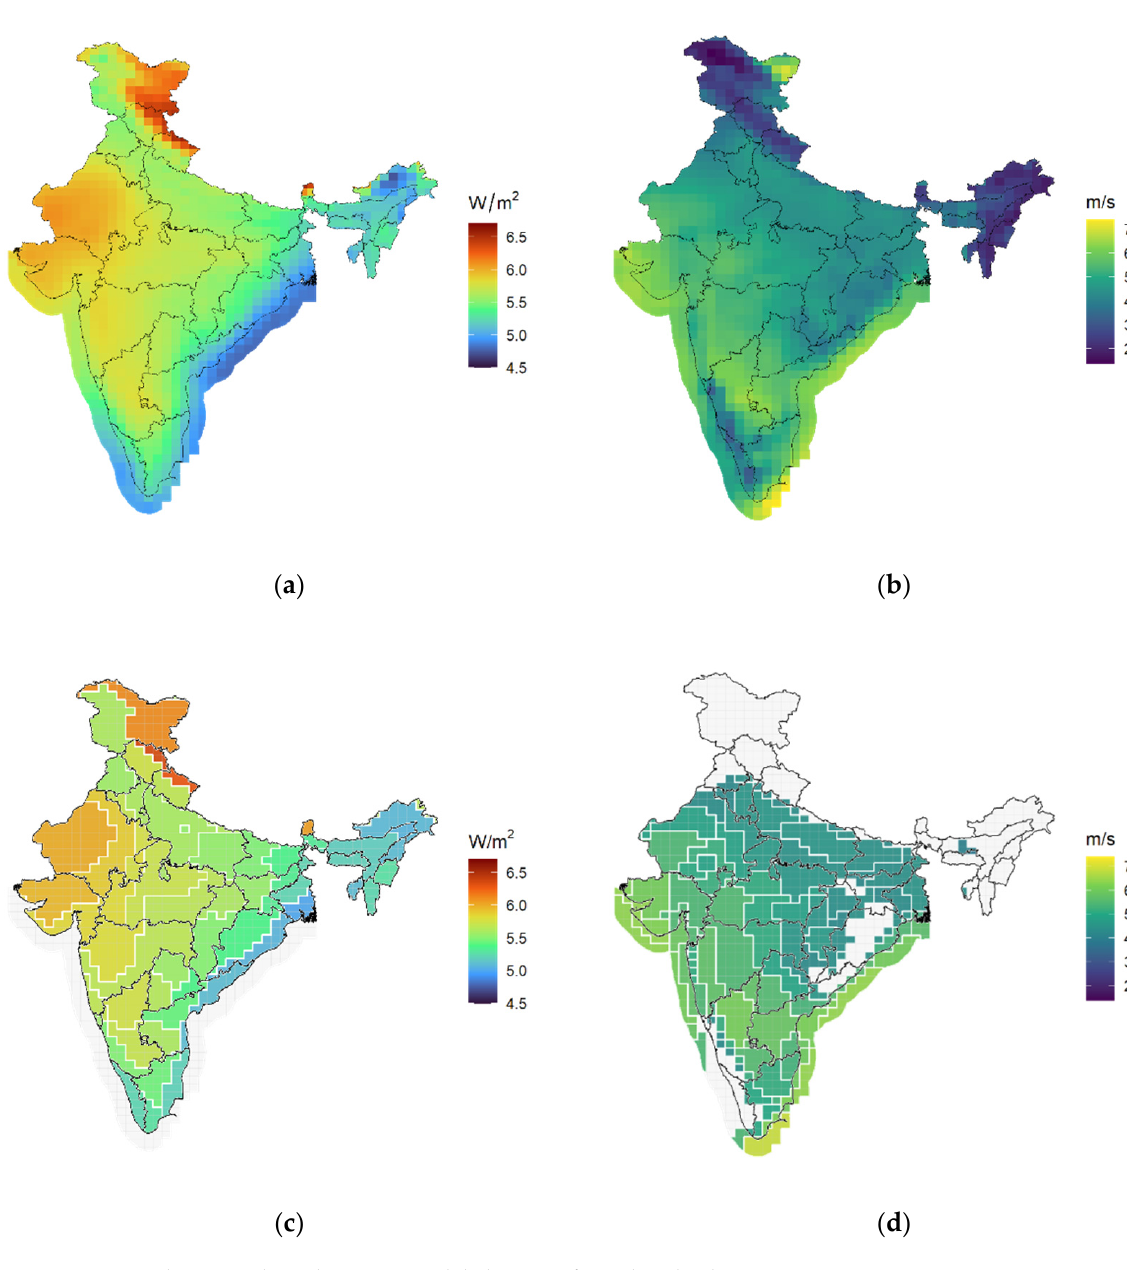
Figure 2. Geospatial potentials and IDEEA model clusters of wind and solar energy, 41 years average, MERRA-2. Note: Colours in ( c ) and ( d ) represent different clusters within regions. ( a ) Daily average global horizontal irradiance, MERRA-2 grid. ( b ) Hourly average wind speed at 50 m height, MERRA-2 grid. ( c ) Solar resource clusters. ( d ) Wind resource clusters.